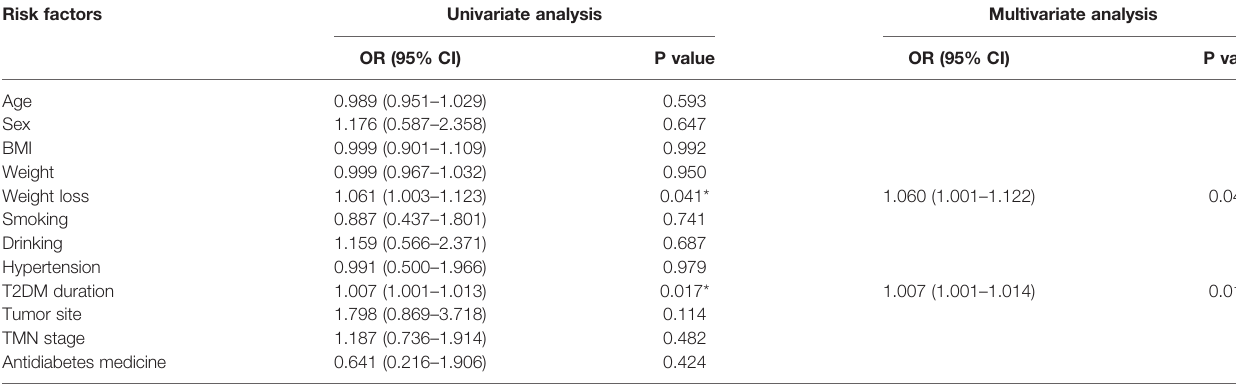
TABLE 3 | Univariate and multivariate analysis of predictive factors for remission of T2DM. Risk